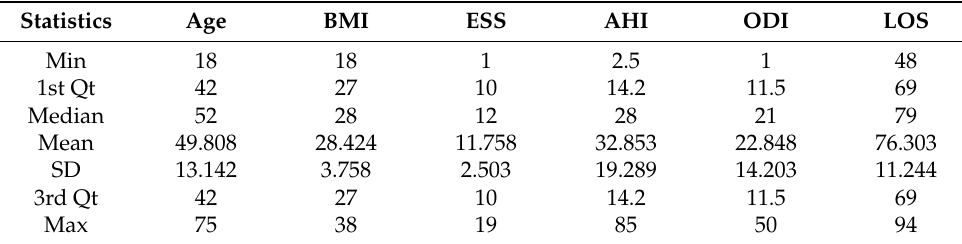
Table 1. Descriptive sample